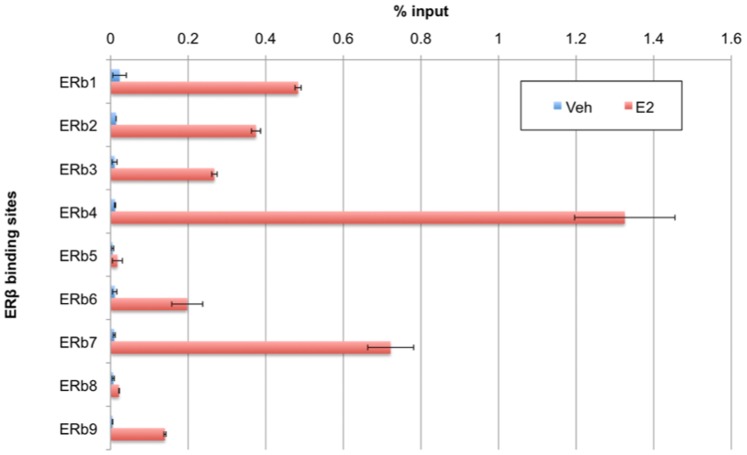
Validation of ERβ binding regions in C4–12/Flag.ERβ cells by ChIP-qPCR.After 1 hour of E2 treatment, C4–12/Flag.ERβ cells were subjected to ChIP assay using anti-Flag M2 antibody. Recruitment of ERβ to representative sites was confirmed with qPCR. (Error bars = standard deviation).